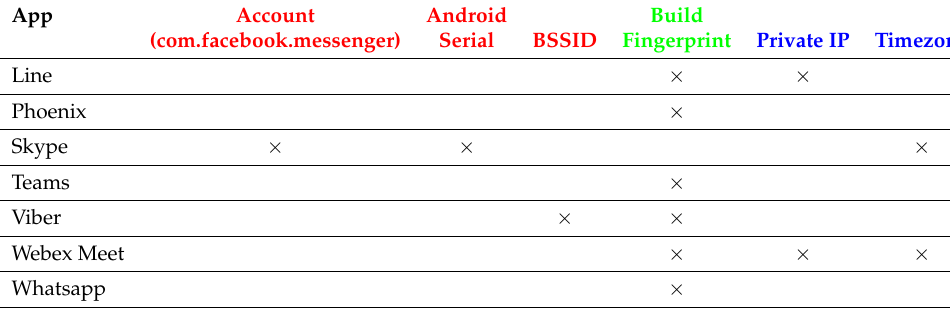
Table 4. Captured data leaks from video conferencing